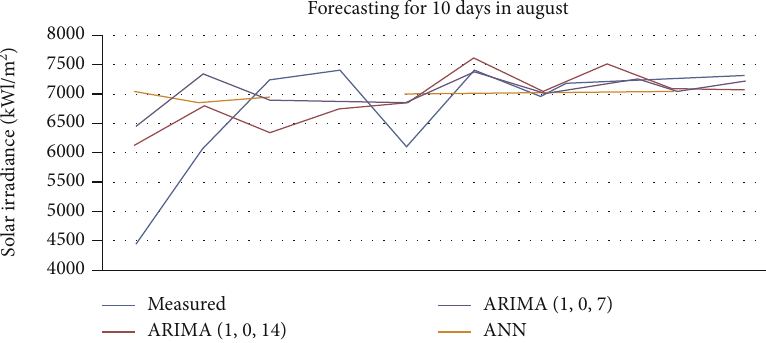
Figure 17: Solar irradiance forecast for Grojdibodu PV park, for 10 days, in August 2013, using the ARIMA and ANN models.